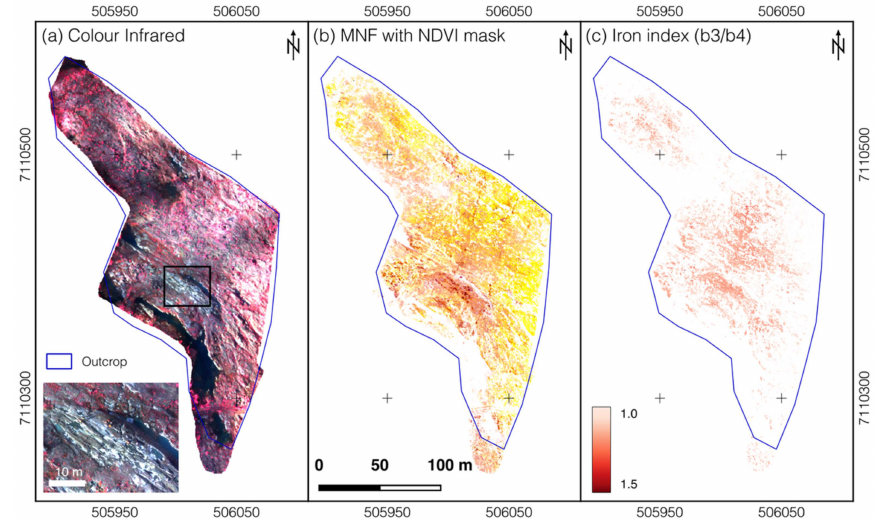
Figure 6. Results of multispectral fixed-wing survey. ( a ) CIR (color infrared) plot of camera bands 3, 2, and 1. Enhanced map pronounces outcrop ridge area, where the surface was cleaned before the survey. ( b ) RGB bands after NDVI cut and MNF transformation with using 4, 3, and 1. ( c ) Band ratio of bands 3 / 4 with 735 / 790